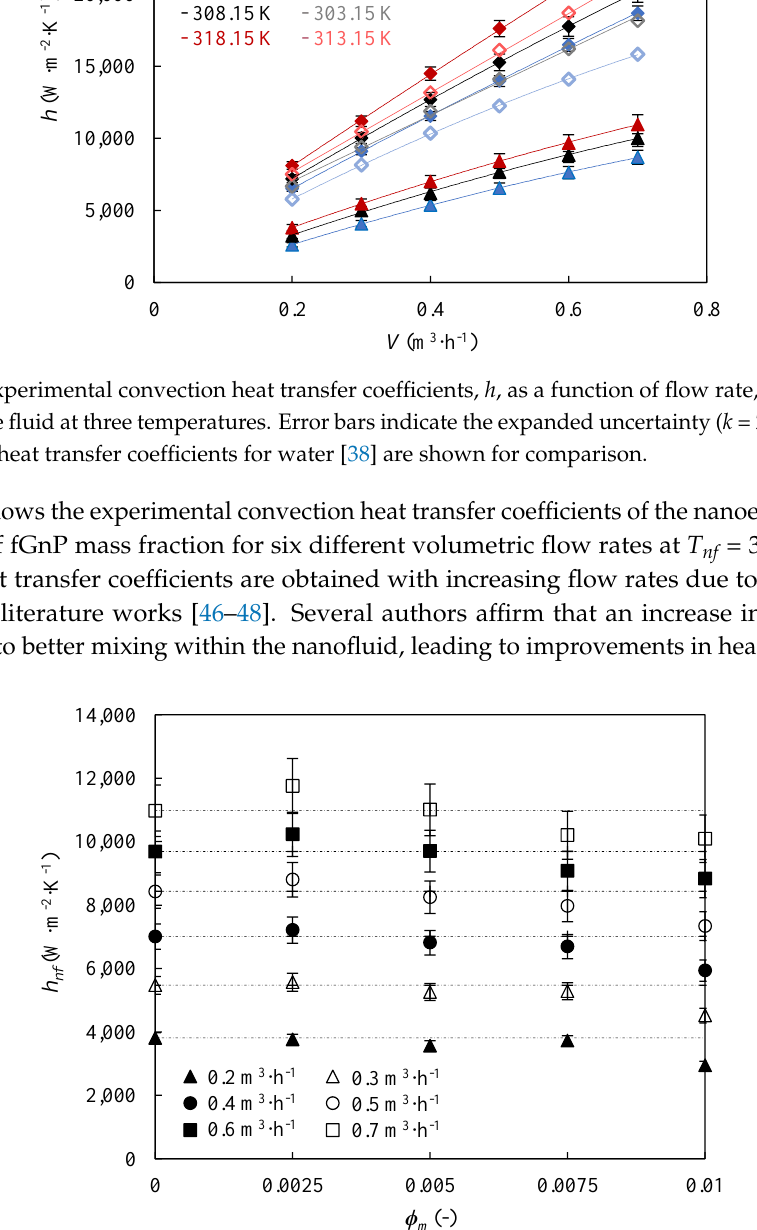
Figure 4. Experimental convection heat transfer coefficients, h nf , the nanoenhanced coolant as a function of fGnP mass fraction, ϕ m , for 6 different volumetric flow rates at T nf = 318.15 K. Error bars indicate the expanded uncertainty (k = 2).